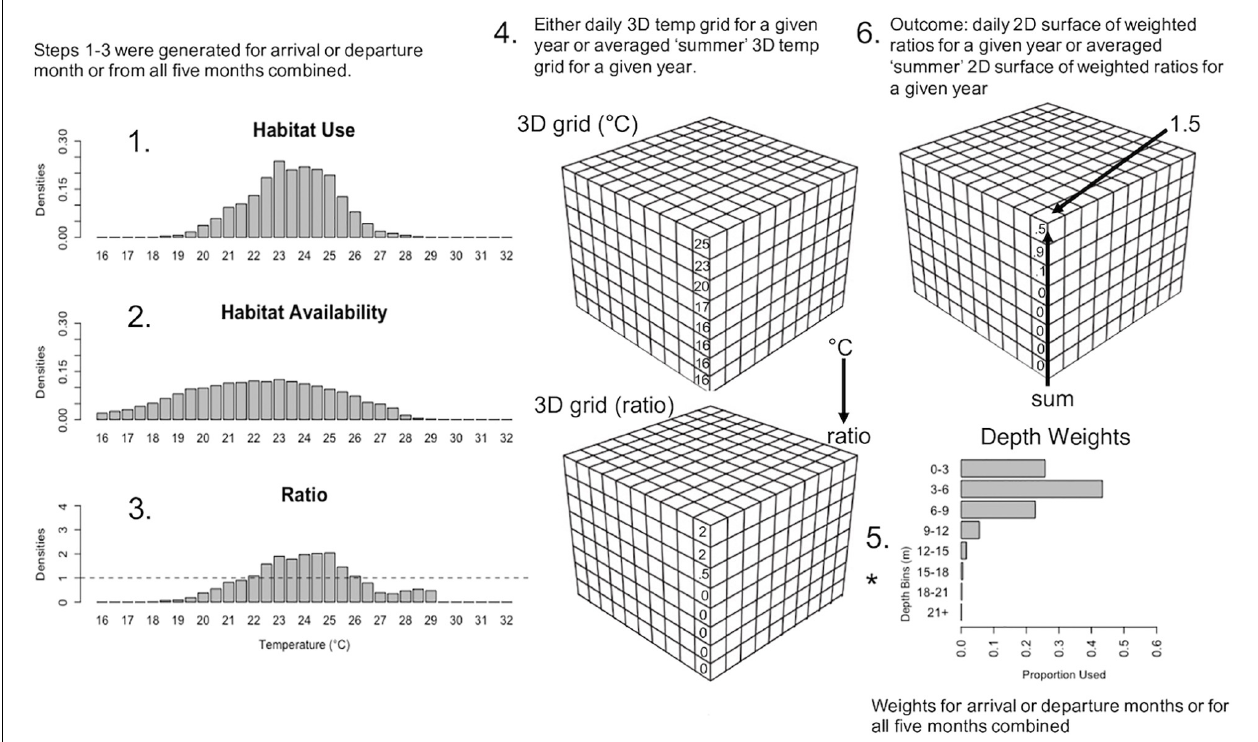
FIGURE 1 | Schematic of the habitat model and how Chesapeake Bay temperature data for specific time periods were run through it. Step 1: Histogram of habitat use densities from data loggers of tagged fish in Chesapeake Bay averaged over a specified time period; 2 arrival months (May, Jun.), 2 departure months (Aug., Sept.), and all 5 summer months combined (May–Sept.). Step 2: Histogram of habitat availability densities generated from daily 3D temperature arrays from Chesapeake Bay (ChesROMS-ECB model), summarized vertically into eight depth bins combined for each of the aforementioned time periods. Step 3: Ratios generated by dividing habitat use densities by habitat availability densities for each time period. Step 4: Either daily 3D arrays (for arrival and departure months) or 3D arrays averaged across two summer periods (May 15–Sept. 30 and Jun. 1–Aug. 31) were extracted from the ChesROMS-ECB model and ratios from Step 3 were assigned to each grid cell at each depth bin based on temperature in that grid cell. Step 5: The vertical habitat distribution of fish in Chesapeake Bay from data loggers was used to generate a depth weighting factor for the above eight depth bins, for each time period. The ratios generated in Step 4 were then multiplied (*) by the appropriate depth weighting factor based on each ratio’s depth in each grid cell for each time period. Step 6: Sum the weighted ratios through the water column to get daily 2D surfaces of weighted ratios for arrival months (May, Jun.) and departure months (Aug., Sept.) for each year and yearly 2D surfaces of weighted ratios for the two summer periods (May 15–Sept. 30 and Jun. 1–Aug.